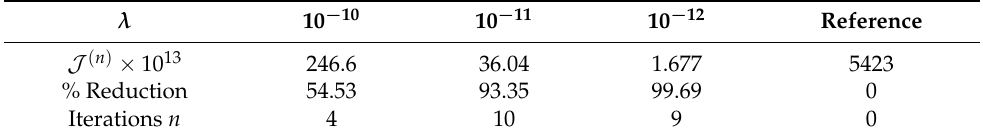
Table 4. Velocity matching case with Dirichlet boundary control—Case 2: objective functional, percentage reduction and number of iterations of the optimization algorithm for different λ values.